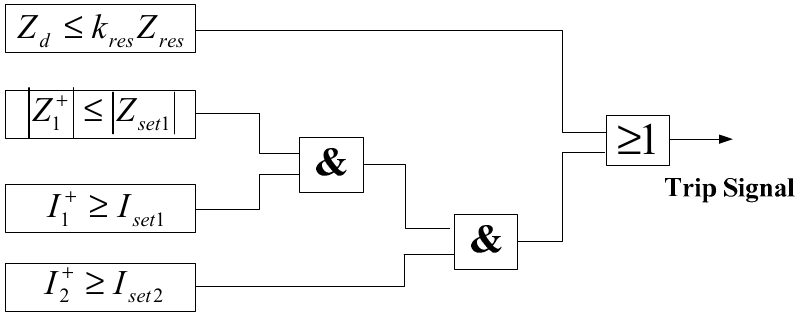
Figure 7. Vertical protection logic diagram based on positive sequence comprehensive